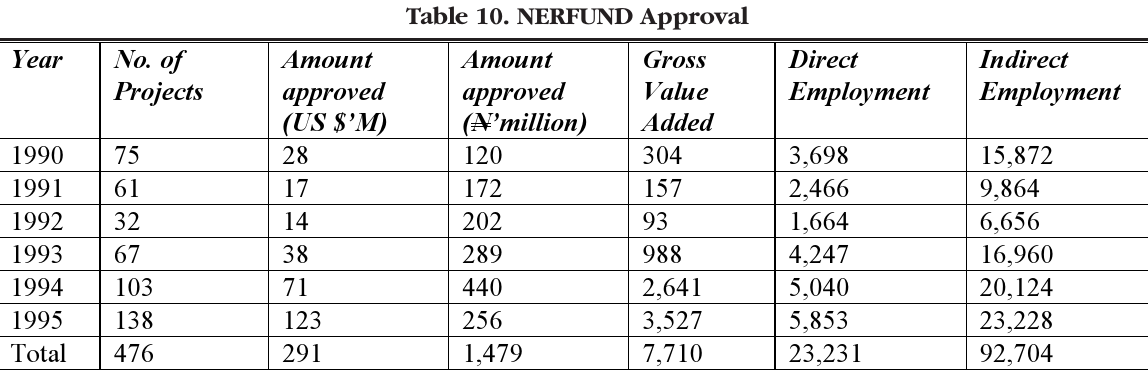
Table 10. NERFUND